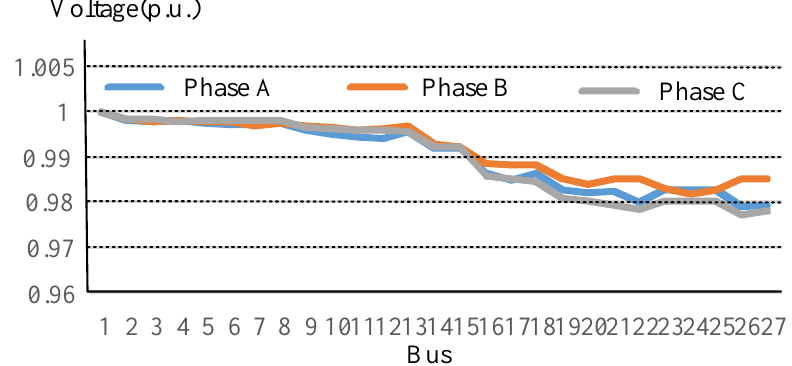
Figure 4. The three-phase voltage profiles of each bus before phase rearrangement at the light load period.